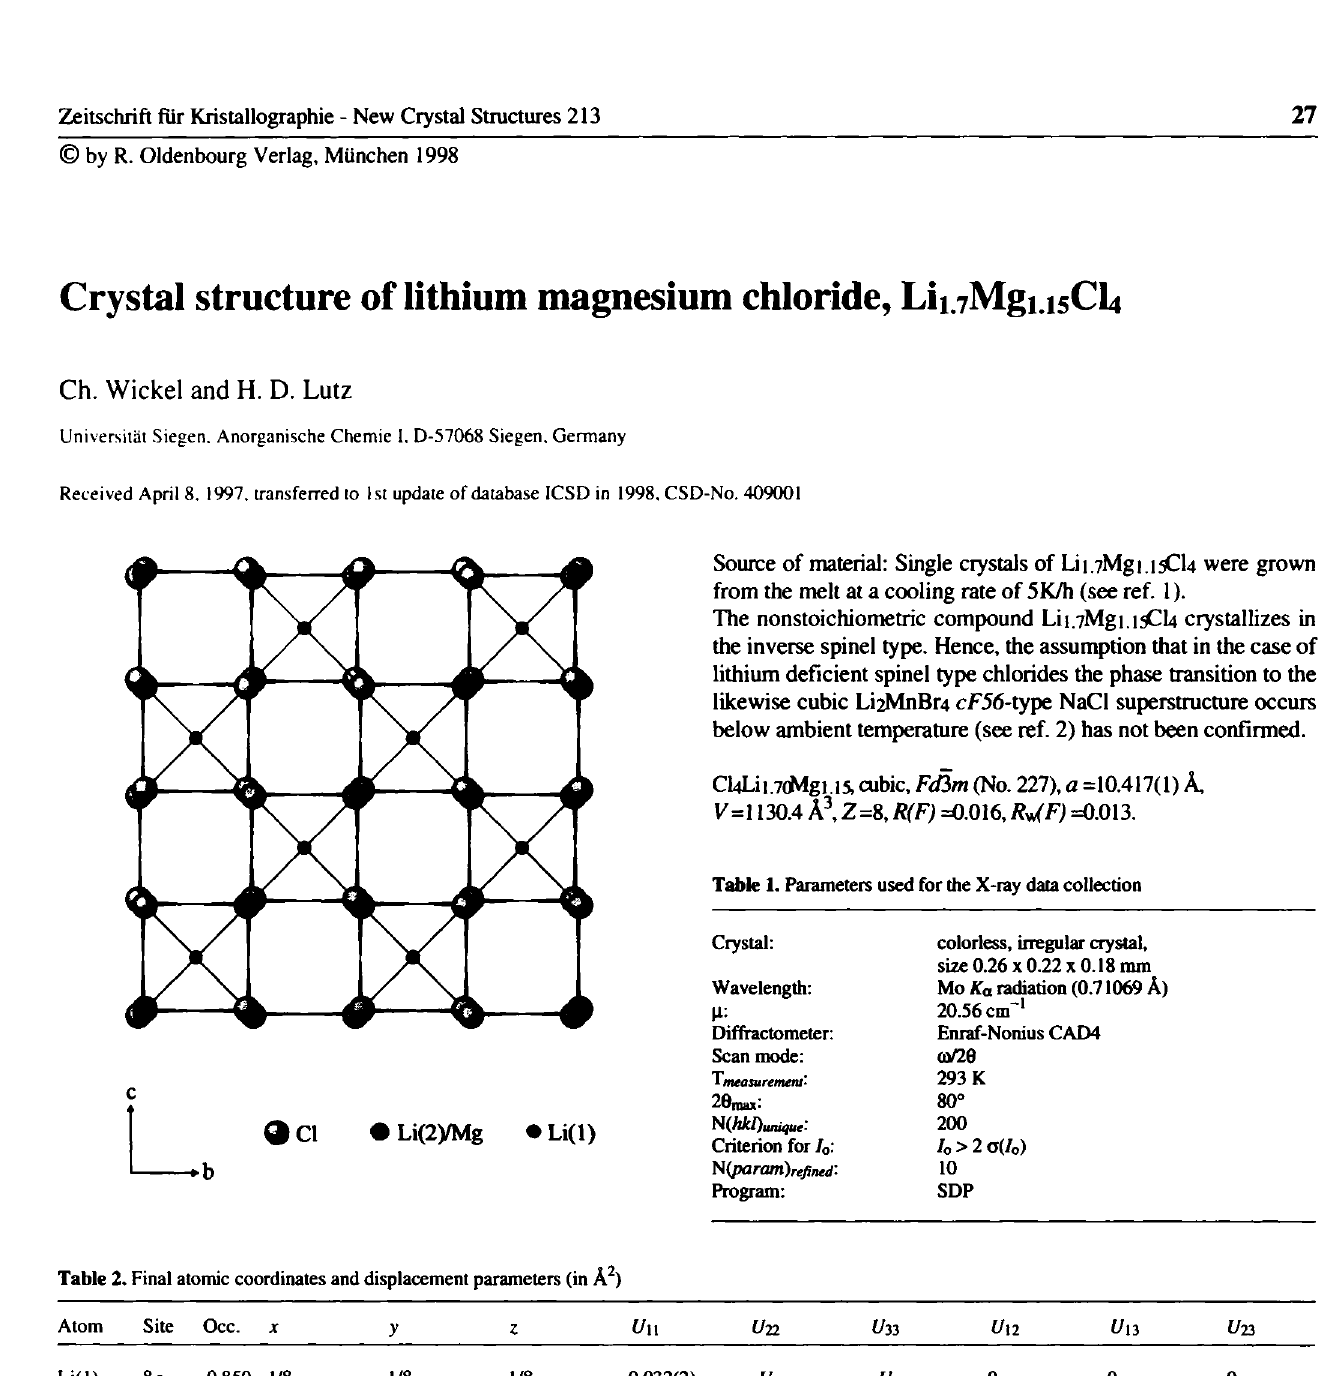
Table 2. Final atomic coordinates and displacement parameters (in Â^) Atom Site